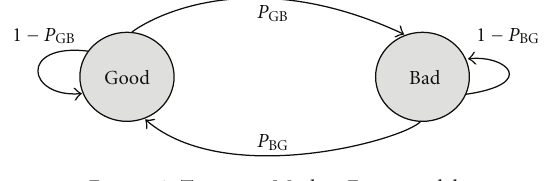
Figure 2: Two-state Markov Error model. Table 1: IEEE 802.16 simulation